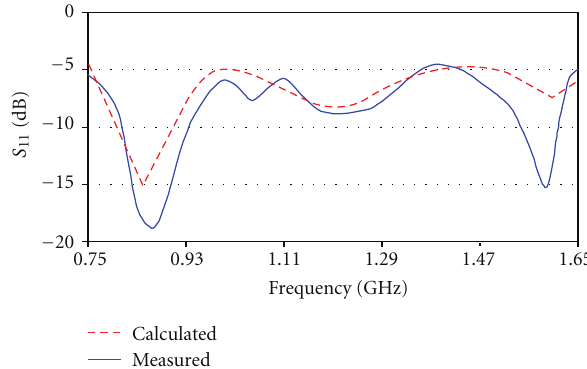
Figure 5: Calculated and measured e ffi ciency of the high-band antenna of the first dual antenna configuration.